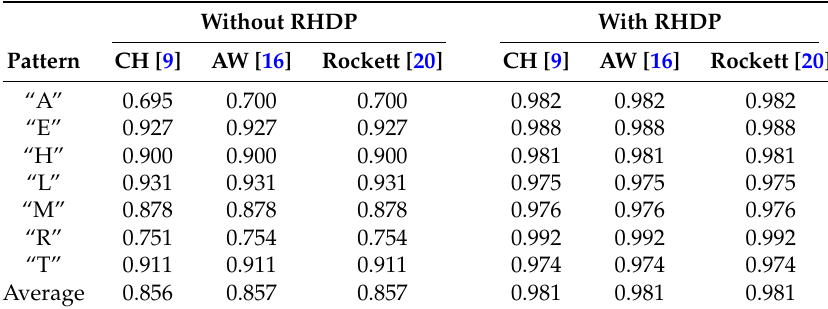
Figure 15. Reconstruction results ( a ) without and ( b ) with the RHDP process are obtained by the three fully-parallel thinning algorithms involved in the proposed approach for comparisons. The reconstruction results of (a) are over-reconstructed, whereas those of (b) are closer to the originals. Table 4. MR measurements for the results given in Figure 15 by applying the presented pattern reconstruction approach with three fully-parallel thinning algorithms. The average MR with the RHDP process is increased 12.5% compared to that without the RHDP process.